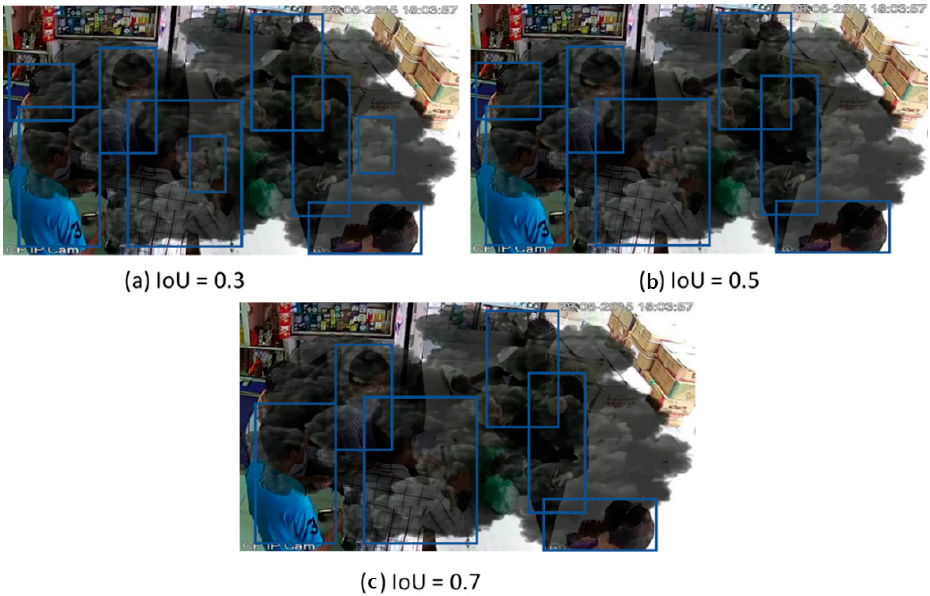
Figure 13. Images showing the results of detection of disaster victims obscured by smoke for IoU = ( a ) 0.3, ( b ) 0.5, and ( c ) 0.7.